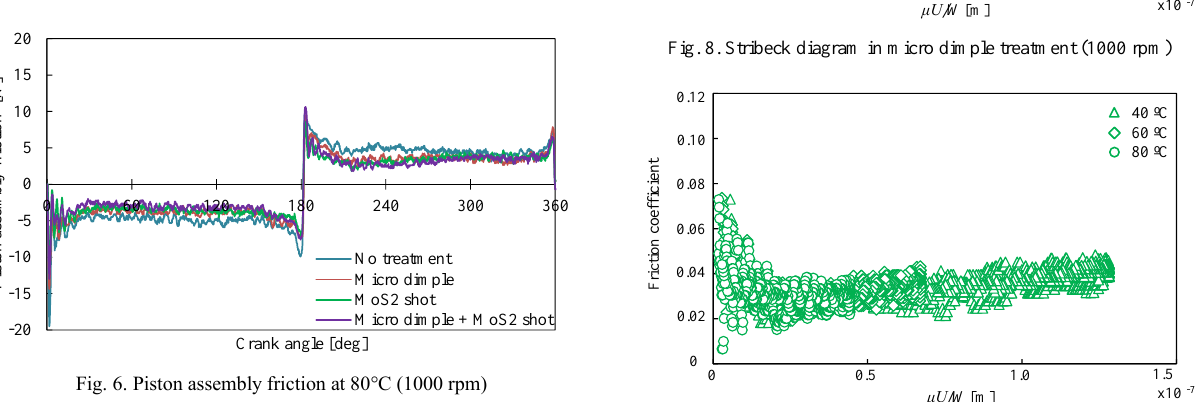
Fig. 5. Piston assembly friction at 60°C (1000 rpm)